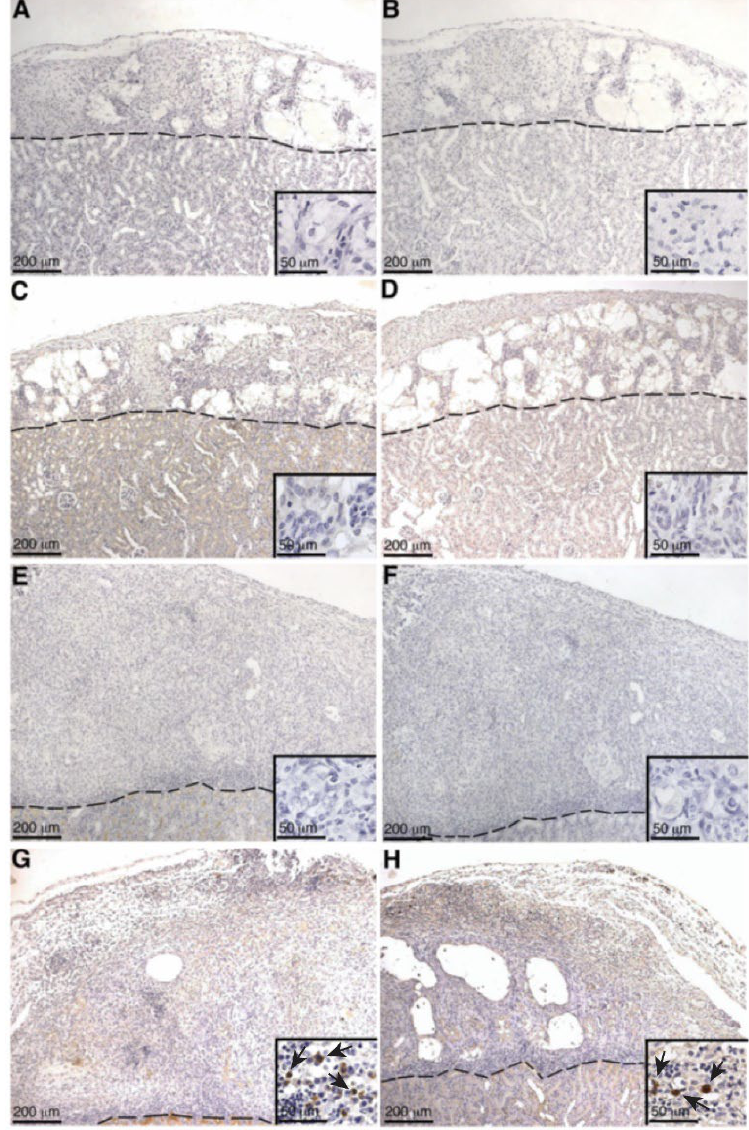
Figure 5. Deposition of antibodies (IgG or IgM) on SC grafts. Tissue sections were collected at days 2 ( A , B ), 5 ( C , D ), 14 ( E , F ), and 20 ( G , H ) post transplantation and immunostained for IgG (brown; A , C , E , G ) or IgM (brown; B , D , F , H ). Insets are higher magnifications. A dotted line separates the graft (above the line) from the kidney (below the line). Hematoxylin was used to stain the cell nuclei (blue). Arrows indicate examples of positive staining.